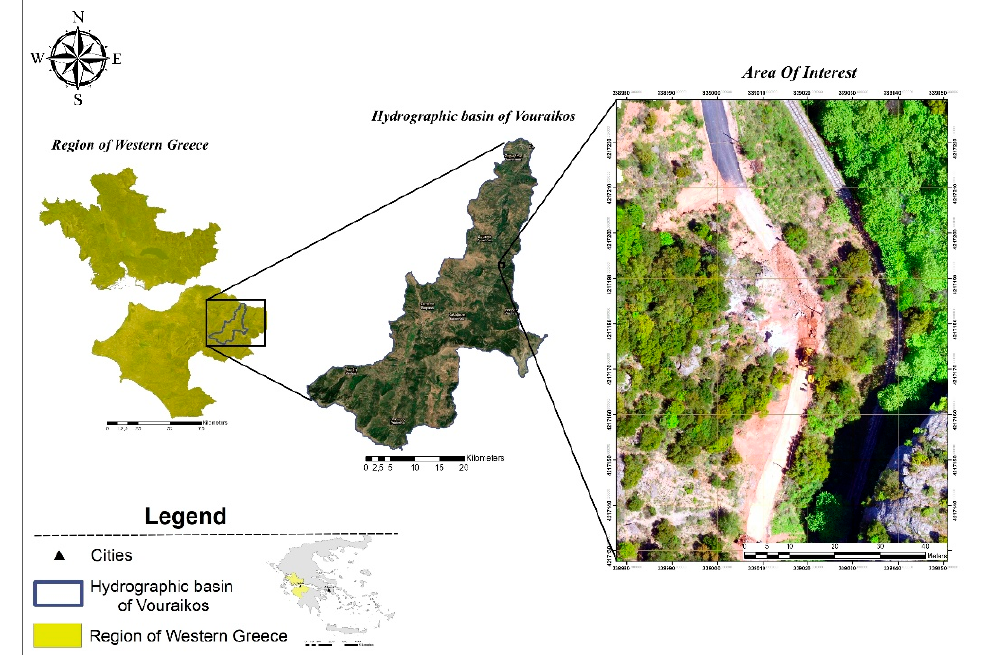
Figure 1. Area of Interest.